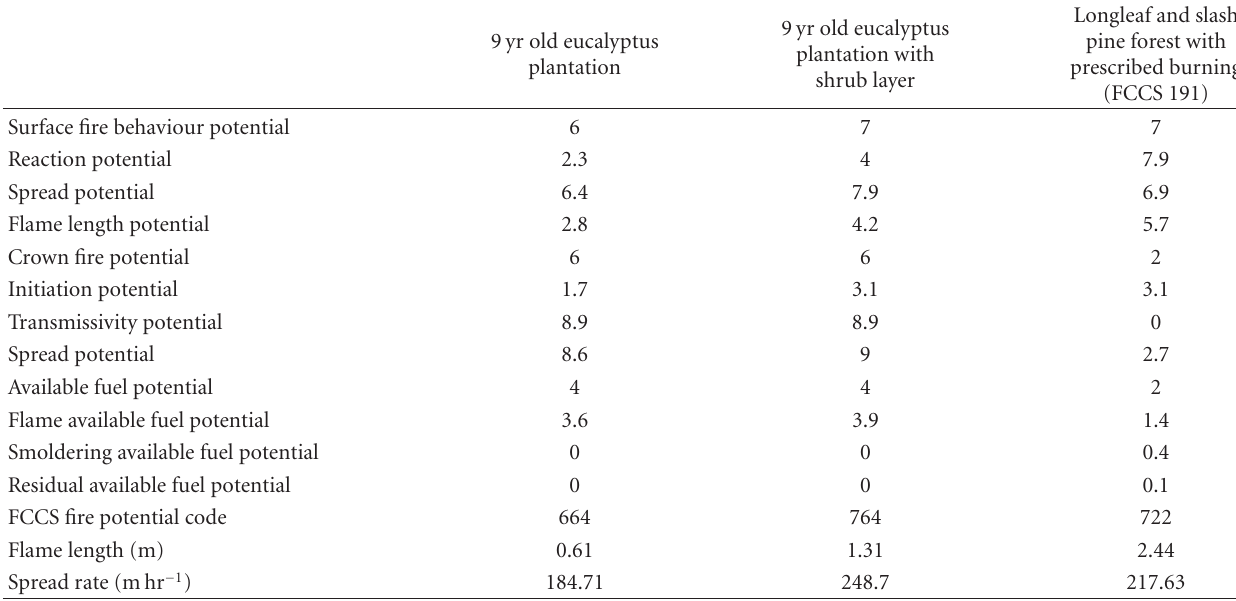
Table 6: E ff ect of introducing a shrub layer on FCCS fire behavior potentials for 9yr old eucalyptus plantation, as compared to a longleaf/slash pine stand with the shrub layer managed by periodic prescribed burning.